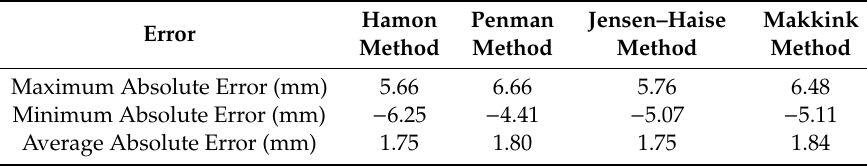
Table 4. Absolute error in the case of calibration and